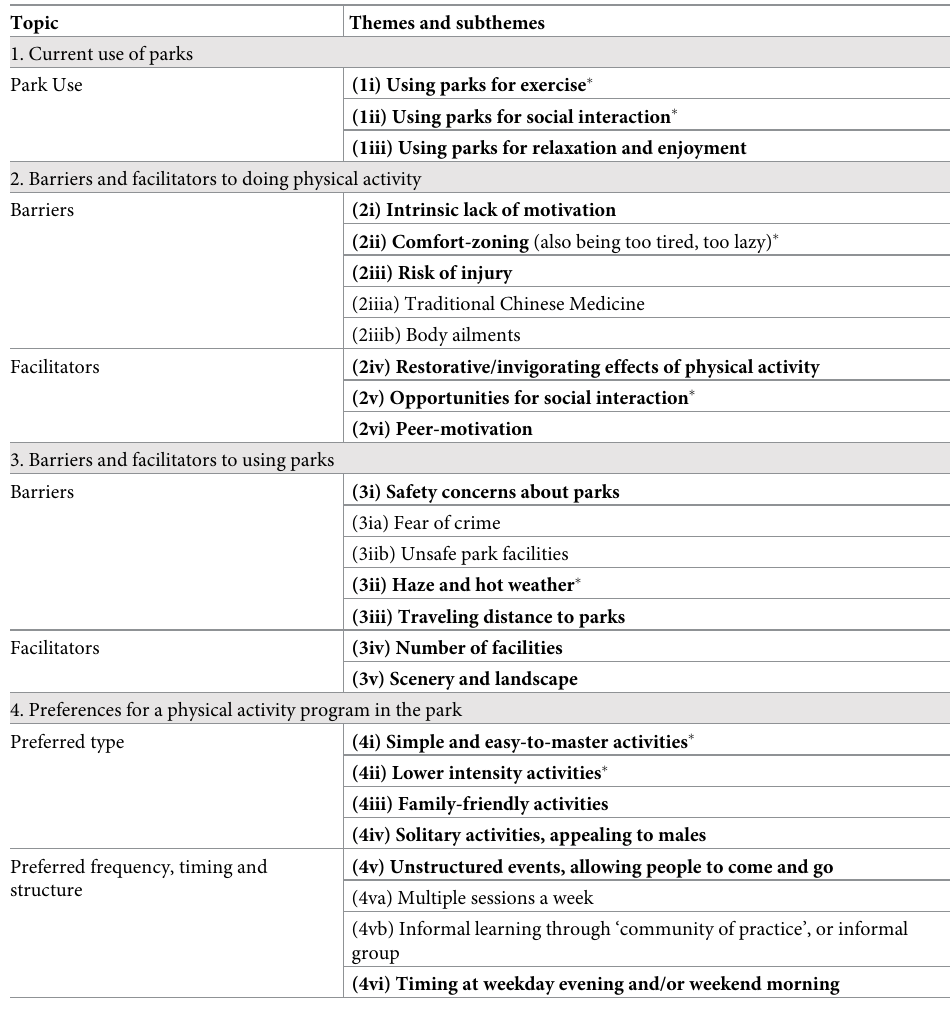
Table 3. Summary of themes and sub-themes derived from the FGs.